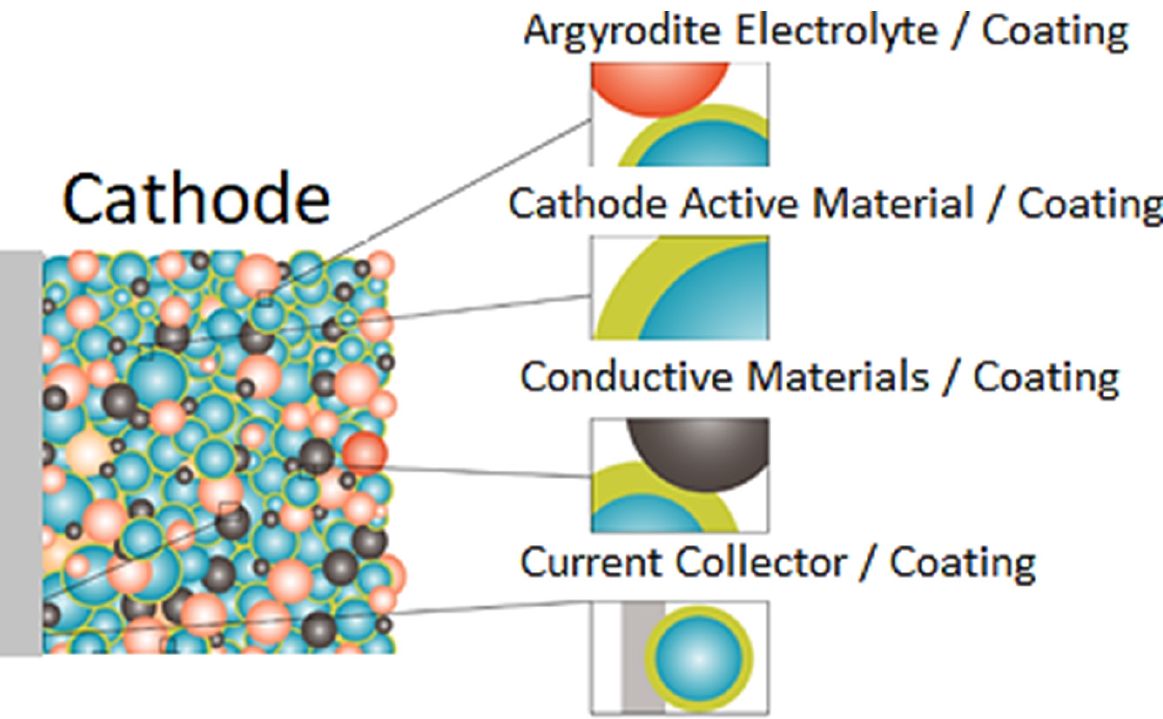
Figure 1. Interface of the coating material with other components of the cathode. The red particles are argyrodite electrolyte, the blue particles are the cathode active material, the black particles are the electron conductive materials, the gray layer is the cathode current collector, and the green layers are the coating (Reprinted/adapted with permission from Ref. [7]. Copyright year: 2022, copyright owner’s name: Eman Hassan).